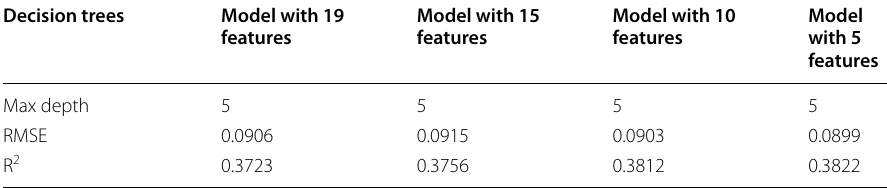
Table 8 Performance metrics with decision trees Decision trees